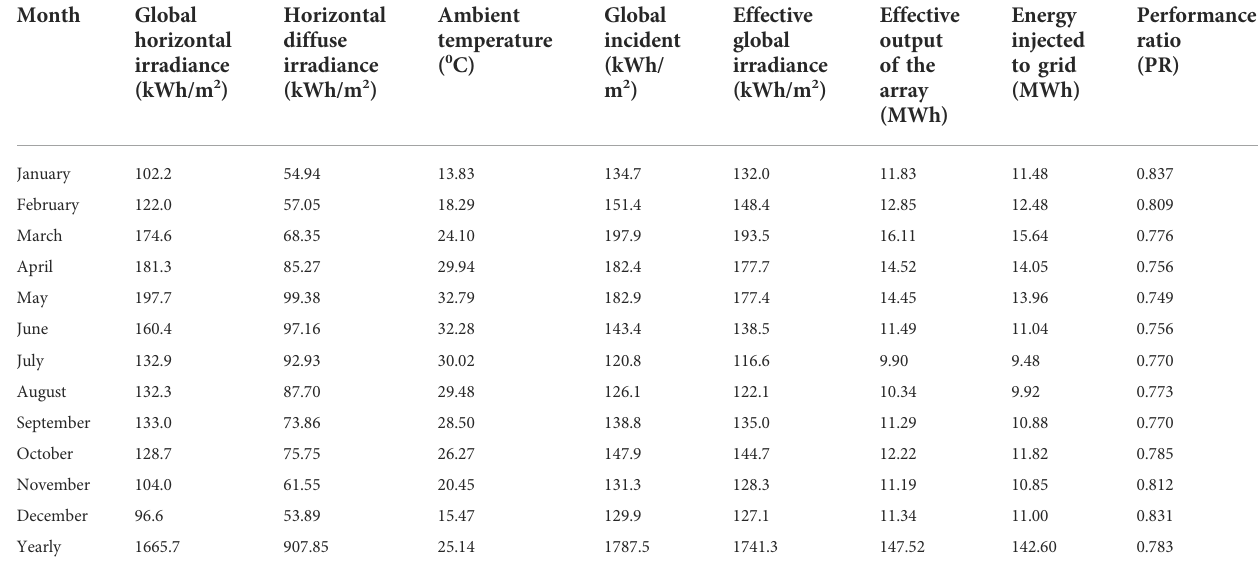
TABLE 5 PV*syst software results of 100 kWp solar PV